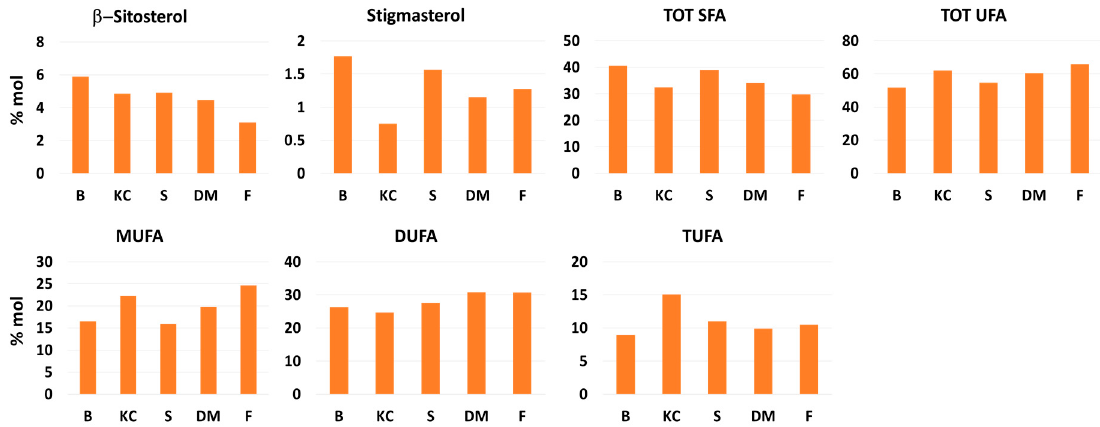
Figure 4. Histograms comparing the concentration (% molar) of metabolites present in tomato organic extracts from the investigated five cultivars (B: Bamano, KC: King Creole, S: Sugarland, DM: DulceMiel, F: Fiaschetta).